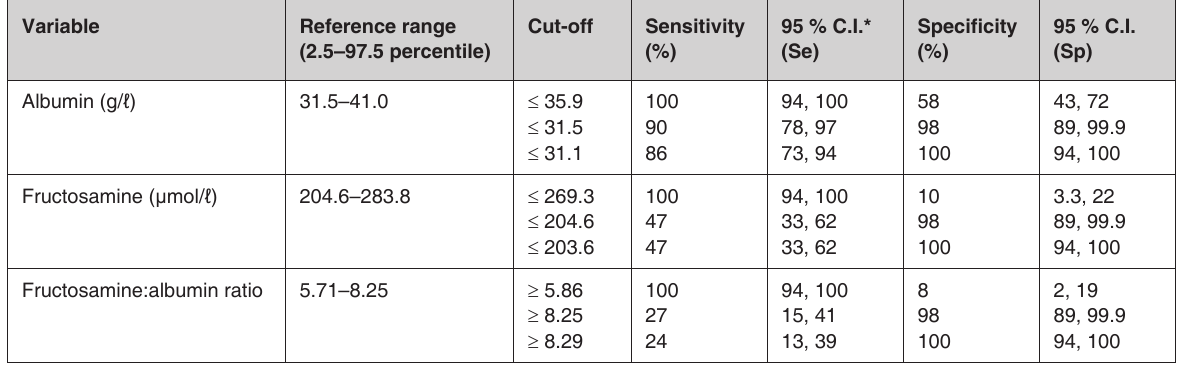
TABLE 3 Reference ranges for albumin, fructosamine and fructosamine:albumin ratio calculated from the adequately nourished cat- tle, and sensitivity and specificity of various cutpoints for detecting undernourished cattle